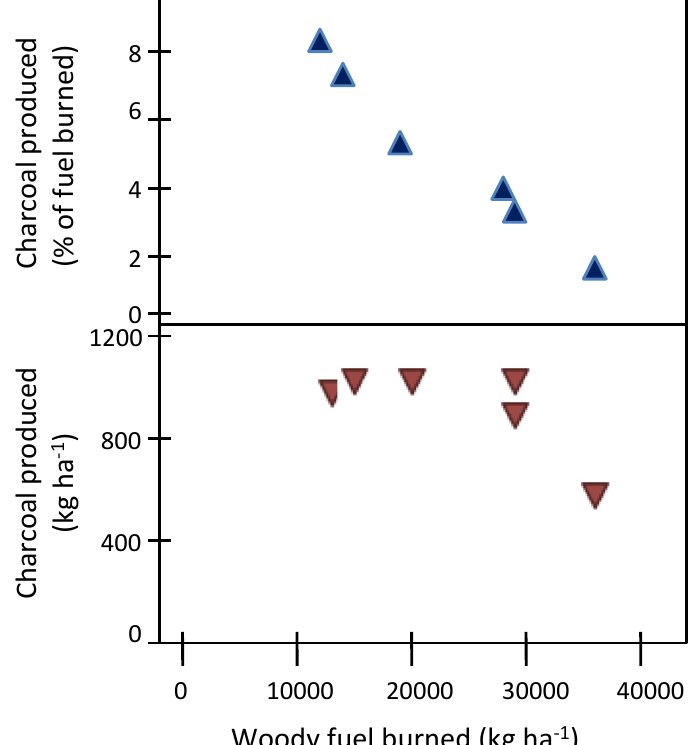
Figure 3. Charcoal produced (top, as % of fuel lost; bottom, as kg ha − 1 ) versus woody fuels lost on six experimental units exposed to wildfire or prescribed fire, Siskiyou Long-term Ecosystem Productivity study,